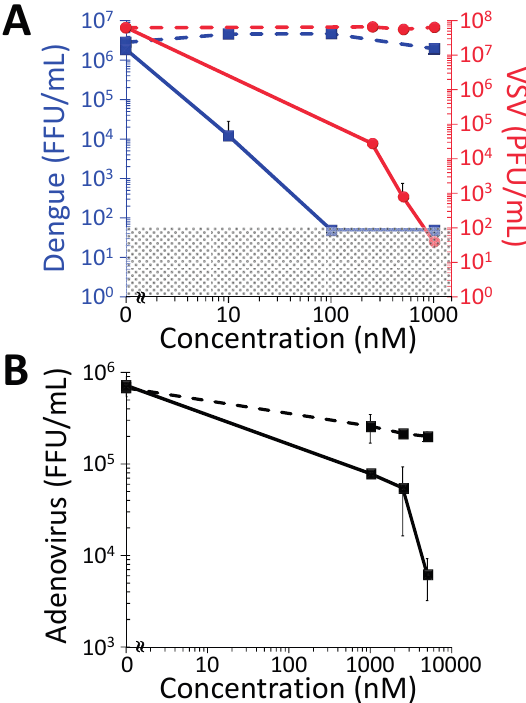
Figure 2. Photodynamic inactivation as a function of DIMPy-BODIPY concentration of ( A ) dengue 1 virus (blue) and vesicular stomatitis virus (VSV, red); and ( B ) human adenovirus-5 (HAd-5). In both panels, the solid lines represent the light treated samples, whereas the dashed lines represent the dark controls. For these studies, the illumination conditions were as follows: 30 min, 400–700 nm, 65 ± 5 mW/cm 2 (total fluence of 118 J/cm 2 ). The detection limits of the assays were 50 FFU/mL for the dengue virus study, 40 PFU/mL for the VSV study, and 66 FFU/mL for the HAd-5 study; data points below the detection limit were set to these values (represented by the shaded area) for graphing purposes. In the cases where error bars cannot be visualized, the error bars themselves were smaller than the marker employed in the